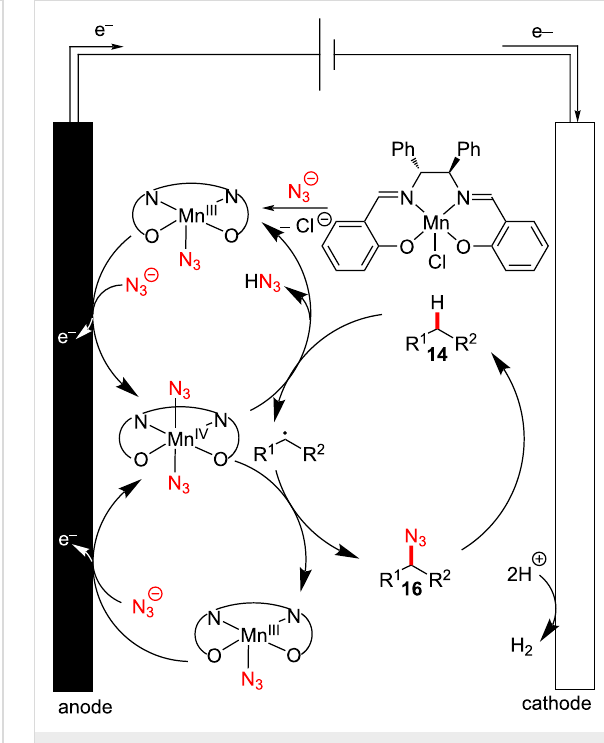
Figure 5: Proposed reaction pathway of manganaelectro-catalyzed late-stage C–H